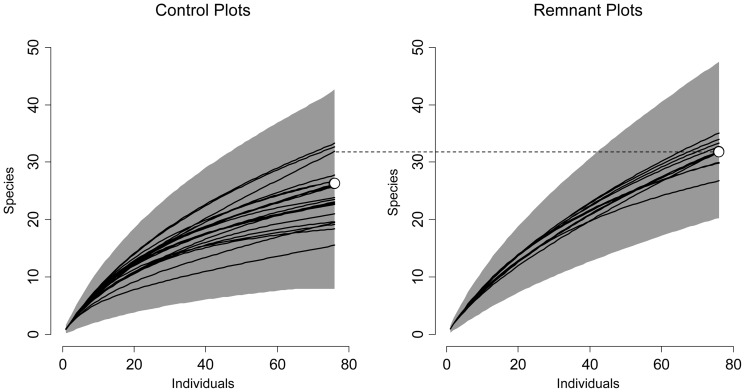
Extrapolated species accumulation curves.Species accumulation curves for remnant and control plots, for all stems ≥5 cm DBH. All species accumulation curves are extrapolated to 76 individuals, the greatest number of individuals found in one plot (min individuals in a plot  = 30, mean  = 53.6). White dots indicate mean species richness for all remnant or control plots. The dashed line allows for comparison of remnant and control plot means.